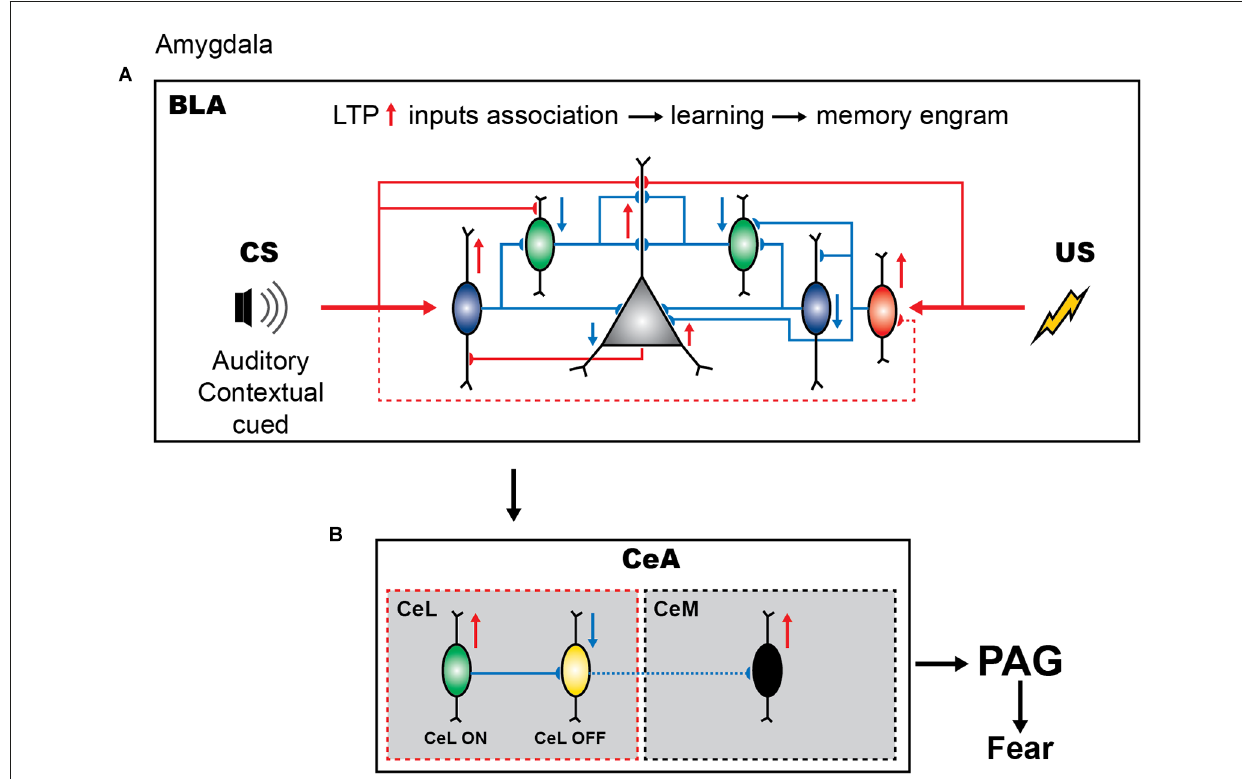
FIGURE1 Inhibitory circuits of amygdala in fear learning. (A) Presentation of neutral stimulus (CS) elicits the firing of PV+ interneurons (blue) and causes the dendritic disinhibition of principal cells by inhibiting SOM+ cells (green), thus promoting the sensory response and enabling the tone-shock association. In contrast, US presentation results in the dendritic and perisomatic disinhibition due to inhibition of SOM+ and PV+ cells by the upstream VIP+ interneurons (red). (B) The cue-shock associated information is projected to the CeL and causes the activation of the SOM+ expressing CeL neurons (green). These GABAeric neurons regulate the CeM-PAG pathway for the expression of fear by inhibiting the PKC-delta expressing CeL